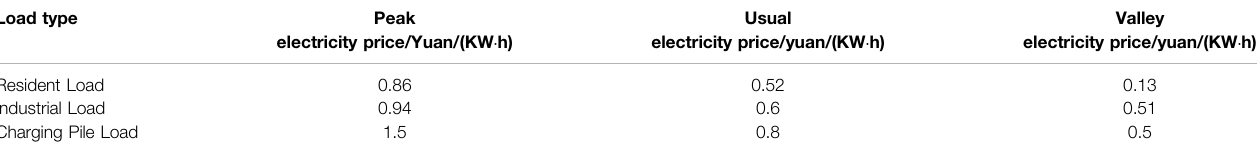
TABLE 2 | Time-of-use electricity price of three types of load.